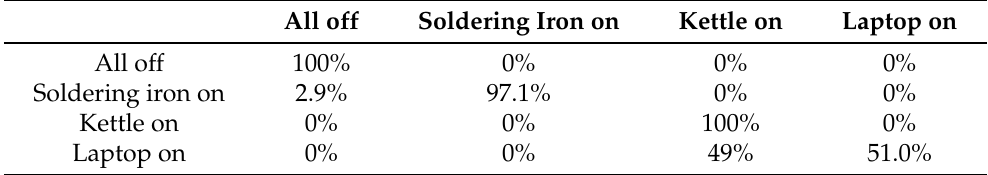
Table 3. Confusion matrix of appliance